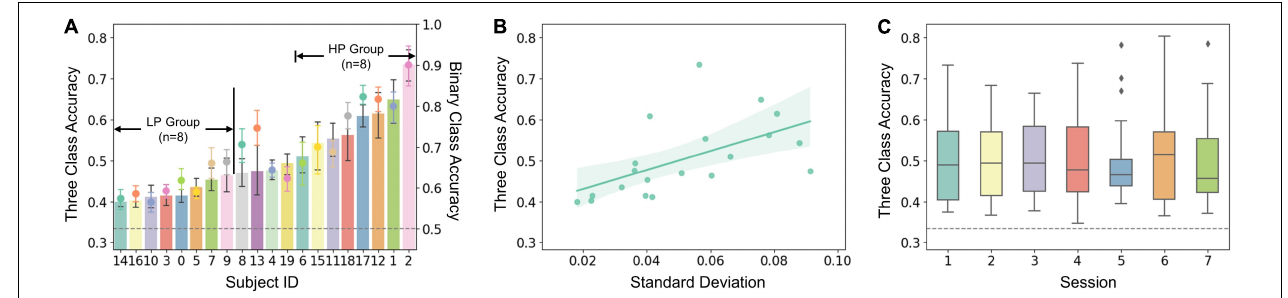
FIGURE 2 | (A) Averaged accuracy of each subject. The histogram and dot plot represent three-class and binary class classification accuracy, respectively. The random levels of 33.33 and 50% are aligned and shown by a gray dotted line. Subjects were sorted and then assigned to the High Performance (HP, n = 8) and Low Performance (LP, n = 8) group according to the three-class accuracy performance. (B) Correlation between SD and three-class accuracy ( r = 0.56, p = 0.01). Each dot represents a subject. (C) Averaged three-class accuracy of each session.